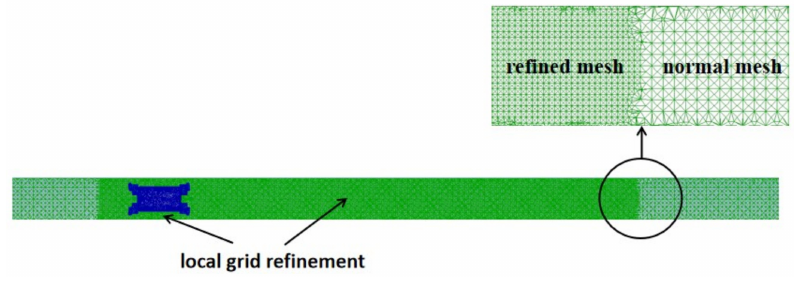
Figure 3. Mesh settings. Table 1. Total number of grids and numerical calculation values for the three grid